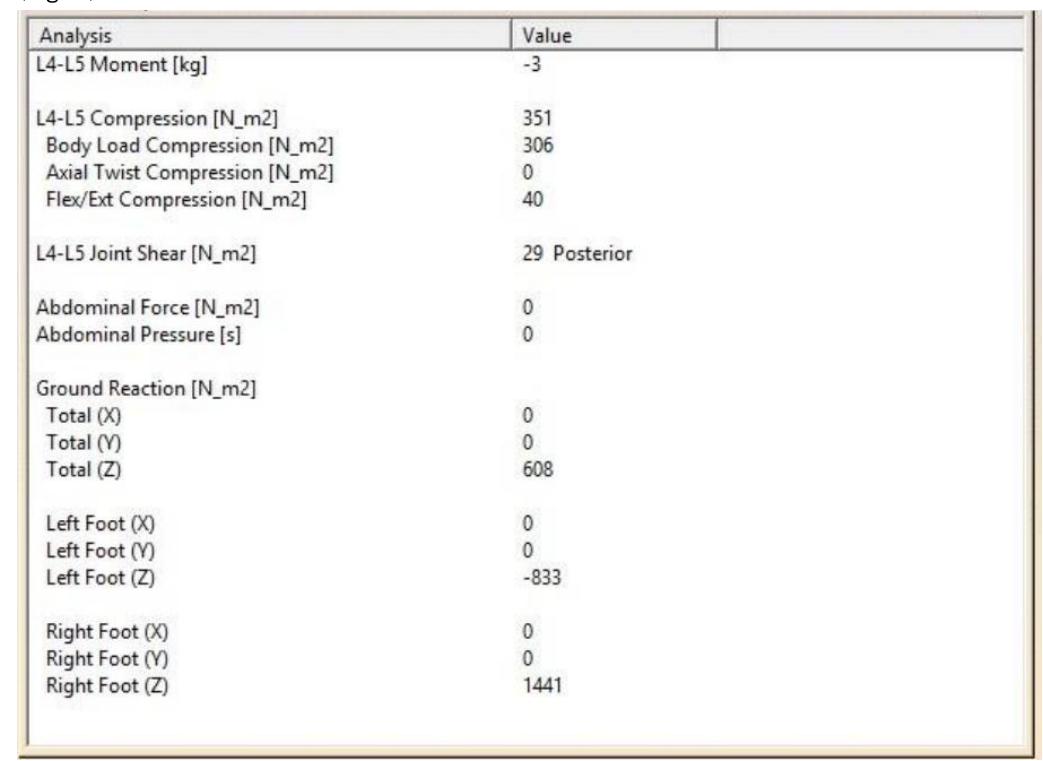
Figure 7. Summary of the biomechnical analysis of the improved body position